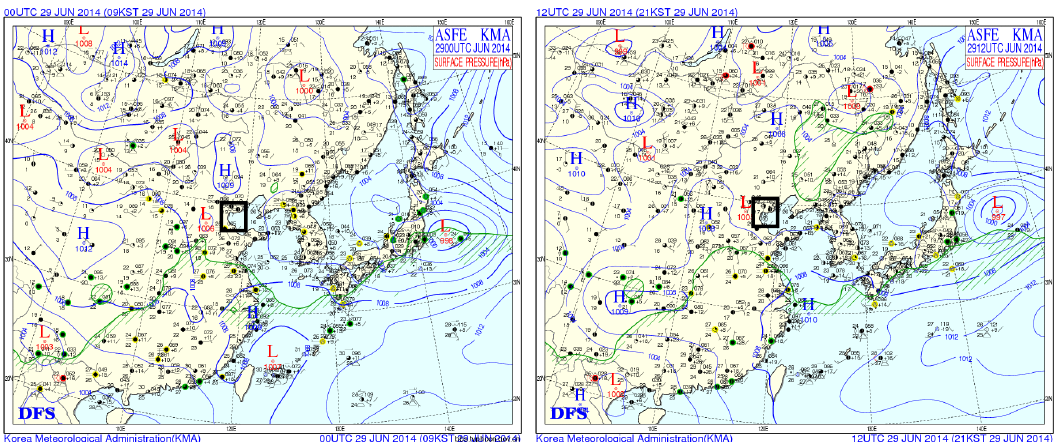
Figure 2. Weather charts at the surface on June 29, 2014 (the location of the study area is indicated by the black rectangle. The charts were obtained from the Korean Meteorological Administration).